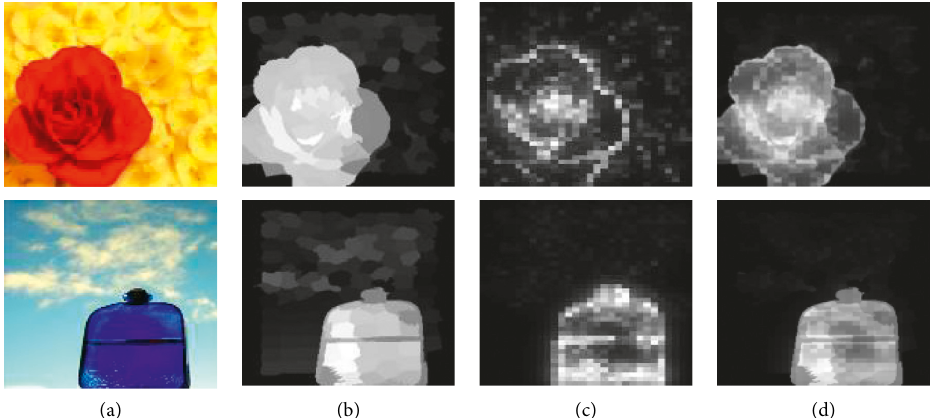
Figure 4: Saliency fusion. (a) Original image; (b) color contrast-based saliency map; (c) hash fingerprint-based saliency map; and (d) final saliency